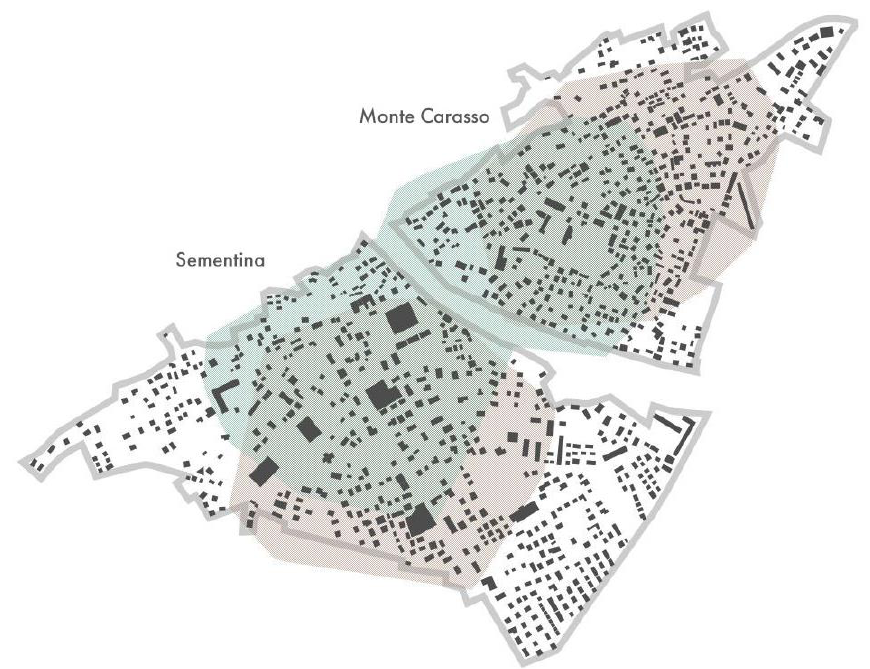
Figure 5. Figure–ground schemes of Monte Carasso and Sementina with delimitation of urbanized Figure 5. Figure – ground schemes of Monte Carasso and Sementina with delimitation of urbanized areas and five-minute pedestrian access zones: green—from town hall; red—from geometric areas and five-minute pedestrian access zones: green — from town hall; red — from geometric center.